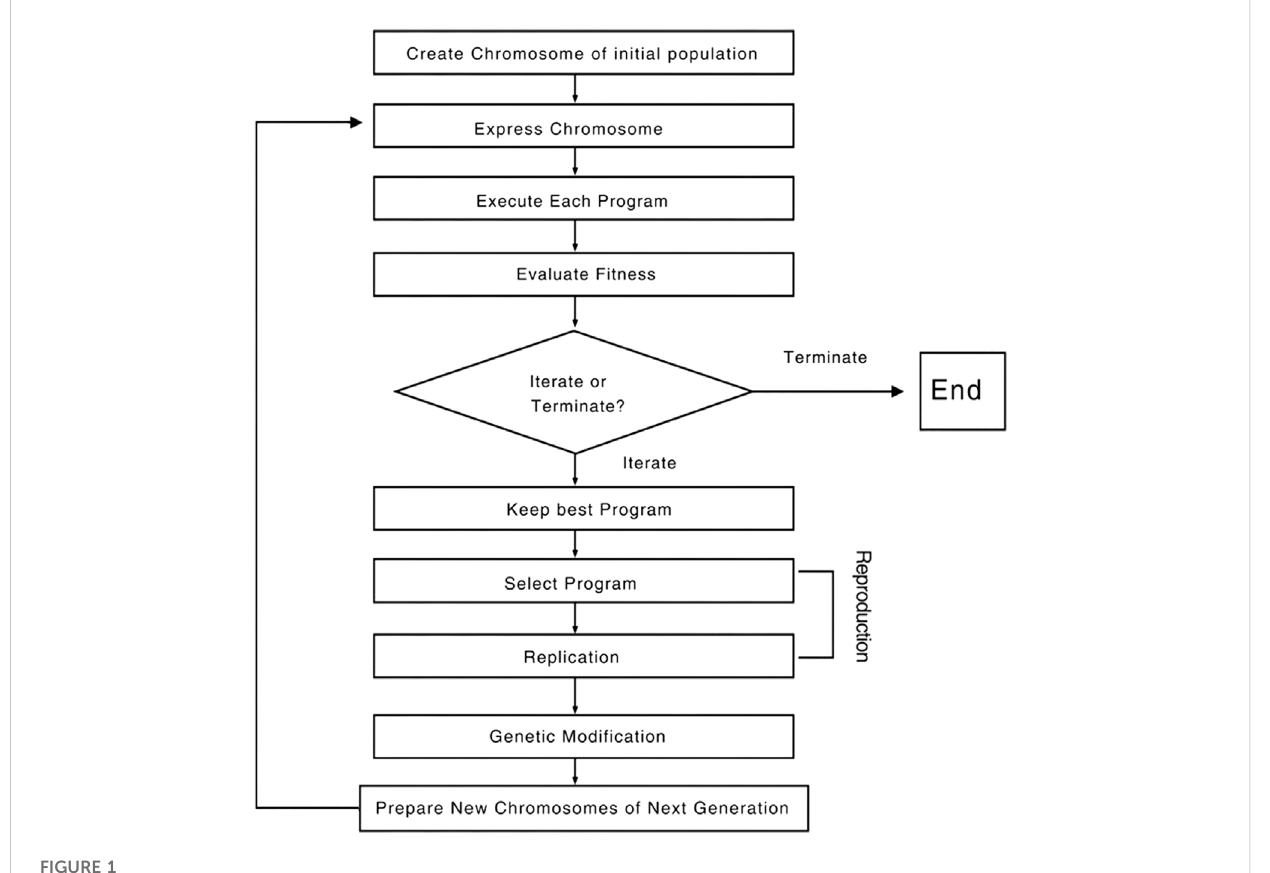
FIGURE 1 Flowchart of GEP